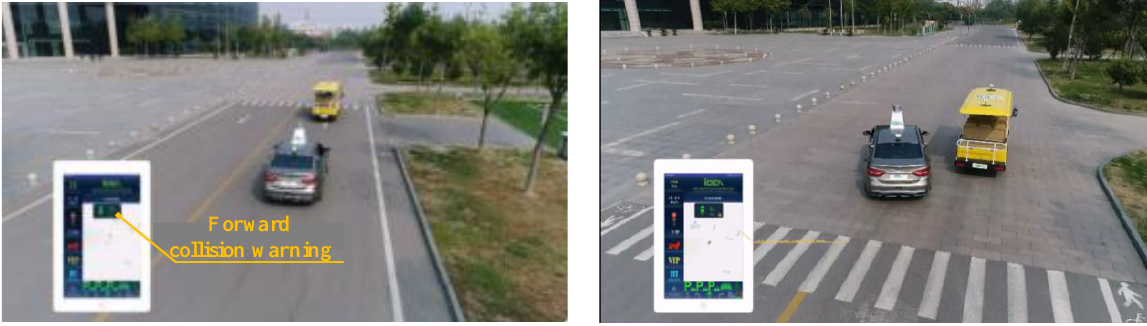
Figure 27. Forward collision warning based on V2X.